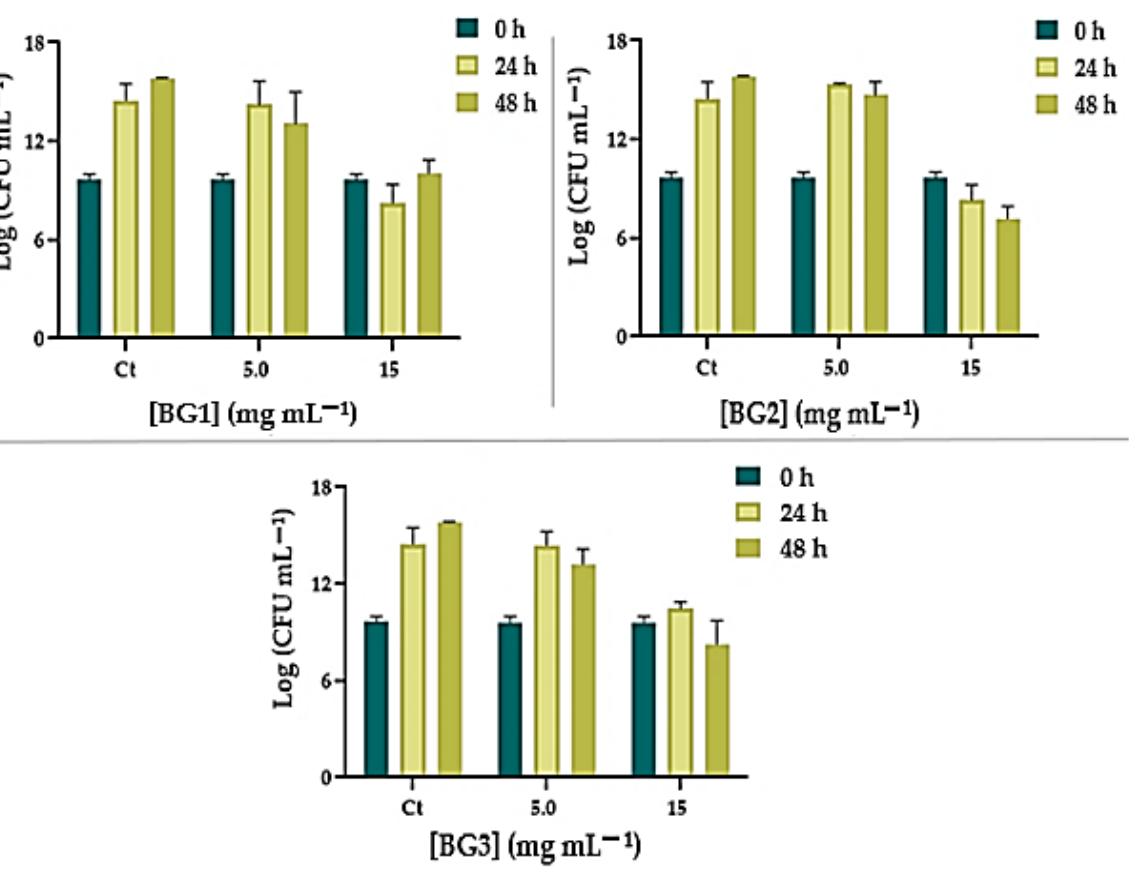
Figure 6. Growth inhibition of E. faecalis ATCC 29212 in the presence of 5 and 15 mg mL −1 BG1 – 3 after 24 and 48 h of incubation. The values are expressed as the means of three independent experiments; error bars indicate the standard deviation.